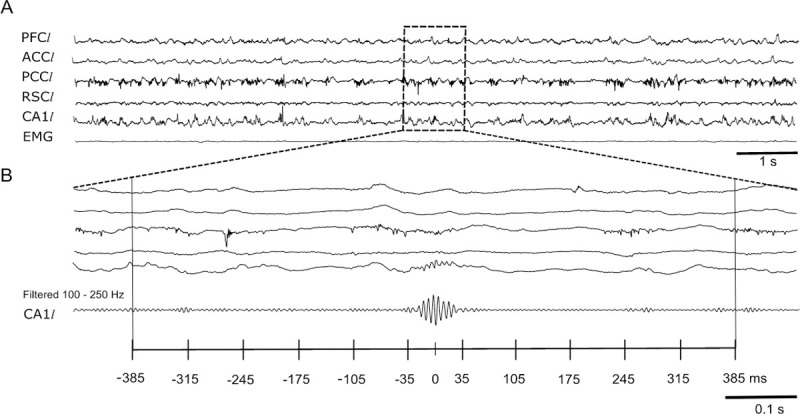
Representative example of an epoch containing SWR.(A) Simultaneous recordings of LFPs from left prefrontal cortex (PFCl), left anterior cingulate cortex (ACCl), left post cingulate cortex (PCCl), left retrosplenial cortex (RSCl), left dorsal hippocampus CA1 (CA1l), and an electromyogram of the neck muscle (EMG) during SWS (B) Enlargement of 1 sec recordings of the LFPs showing SWR oscillation within a 770 ms epoch in raw and filtered data. Notice a single SWR centered in the middle window and no other SWRs occurring before or after it (bottom panel).